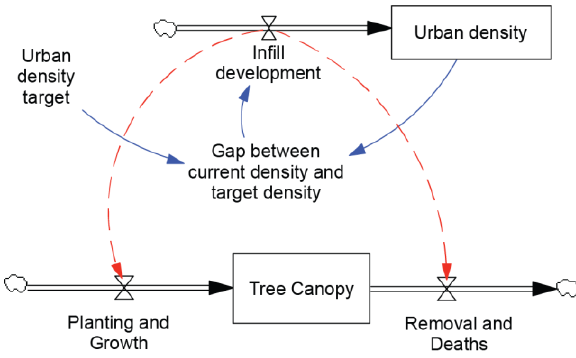
Figure 8. Consequences of Urban Infill on Tree Canopy Levels.